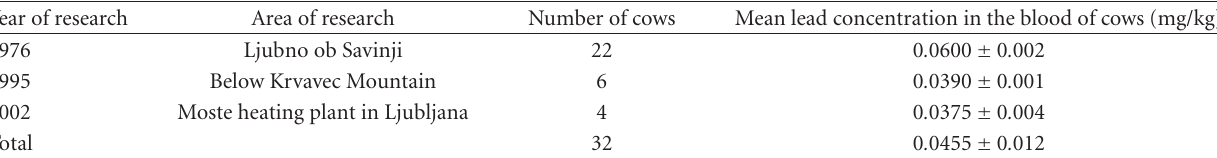
Table 2: Mean ± SD lead concentrations in the blood of 32 cows from the three control areas in Slovenia.